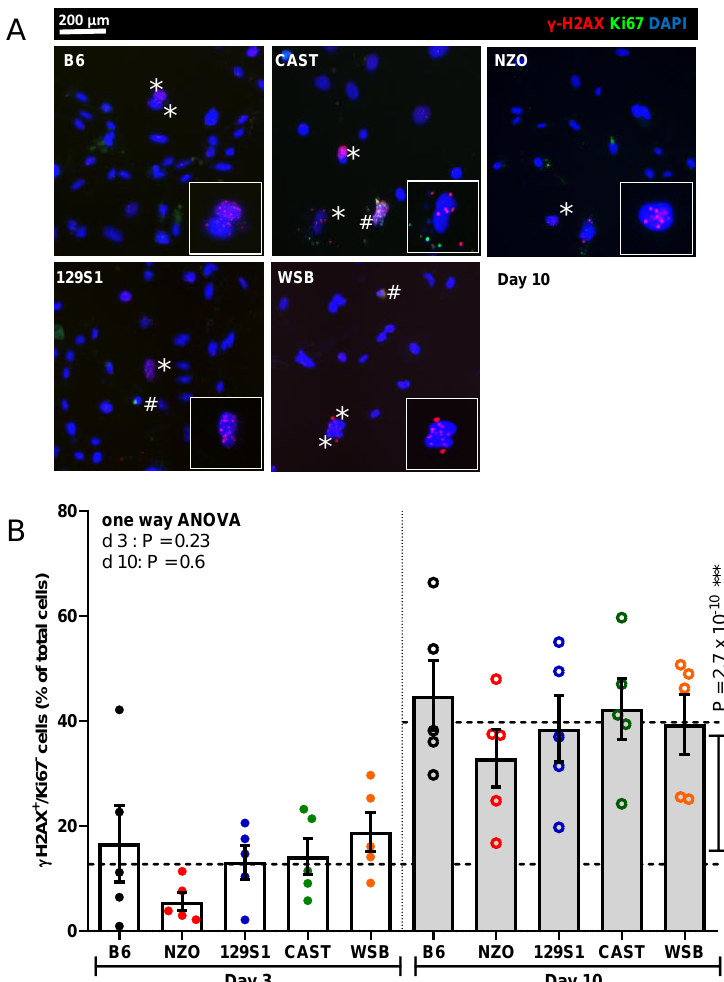
Figure 4. Analysis of cellular senescence using γ H2AX and Ki67 immunofluorescence co-staining. ( A ) Representative images of PTEC at day 10 after irradiation showing immunofluorescent staining for γ H2AX and Ki67. Cells were counted as senescent (marked with *) when Ki67 negative and simultaneously positive for over five γ H2AX foci. Ki67-positive cells are marked with #. Original magnification 400 × . ( B ) Percentage of senescent cells was quantified at days 3 and 10 after irradiation. Results are presented as means ± SEM ( n = 5 mice for each strain). Significance between means of strains and means of time points were tested by the one-way ANOVA and t -test, respectively. Tukey’s test was performed as a post-hoc analysis in the case of multiple comparisons. Results from days 3 and 10 are tested separately.; *** p <